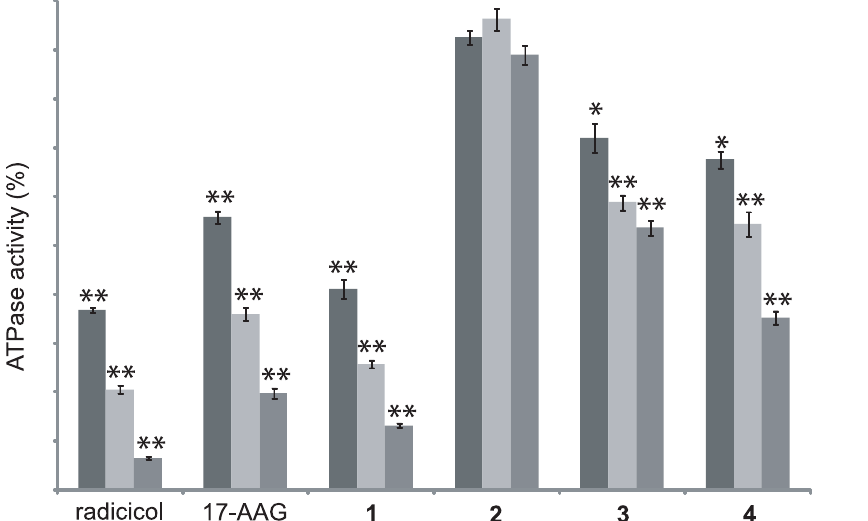
Figure 3. Inhibition of the ATPase activity of Hsp90 by different concentration of compounds 1–4. Radicicol and 17-AAG were used as positive controls. Data are the mean of two independent experiments performed in triplicate and were analyzed by t test (Hsp90 vs Hsp90 + testing compound): *P , 0.05, **P , 0.005.